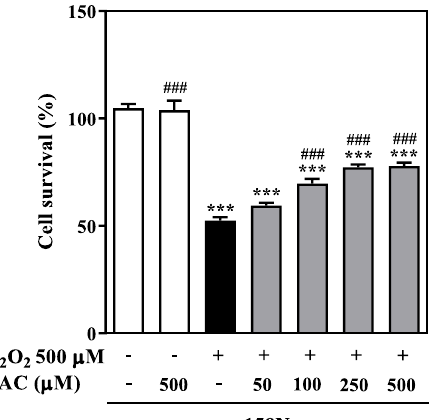
Figure 2. NAC prevents H 2 O 2 -induced oligodendrocyte cell death. 158N cells were treated with H 2 O 2 (500 µ M) for 24 h with and without NAC (50 to 500 µ M). Cell survival was calculated as the percentage of control cells, and the results were expressed as mean ± SEM. Cell survival was quantified using a colorimetric method. Data were analyzed by one-way ANOVA with Tukey’s post-hoc test. *** p < 0.001 shows significance between control (untreated) and treated groups. ### p < 0.001 demonstrates significance between H 2 O 2 alone and NAC treatment groups in the presence and absence of H 2 O 2 .